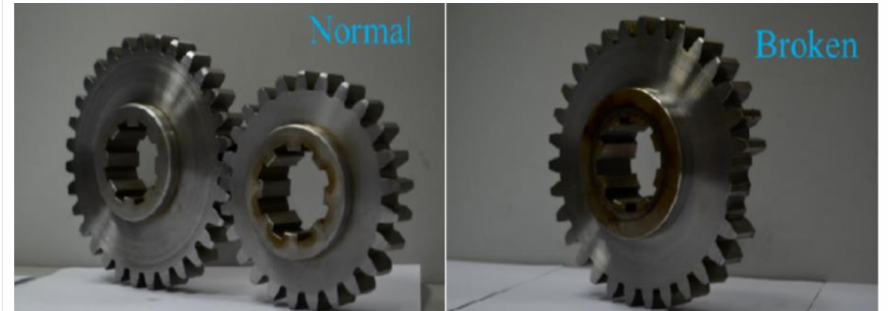
Figure 9. The normal gears and the broken gears.